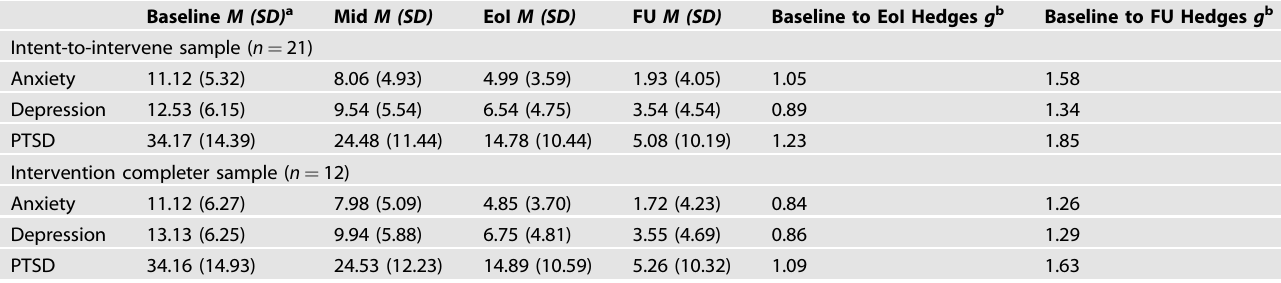
Table 2. Estimated marginal means from multilevel models, raw standard deviations, and Hedges g effect sizes from baseline to end-of-intervention and 1-month follow up for intent-to-intervene, intervention starter and intervention completer